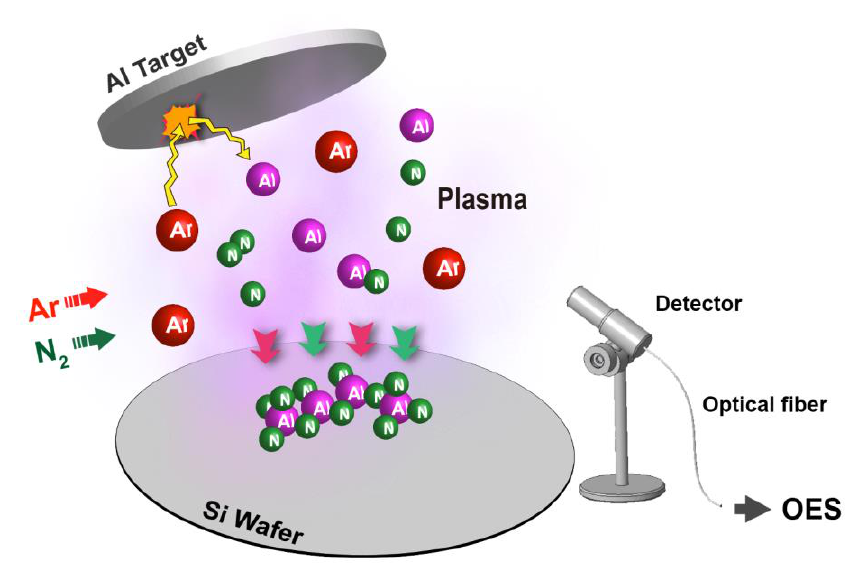
Figure 1. Plasma process reaction during reactive deposition in a sputter chamber.